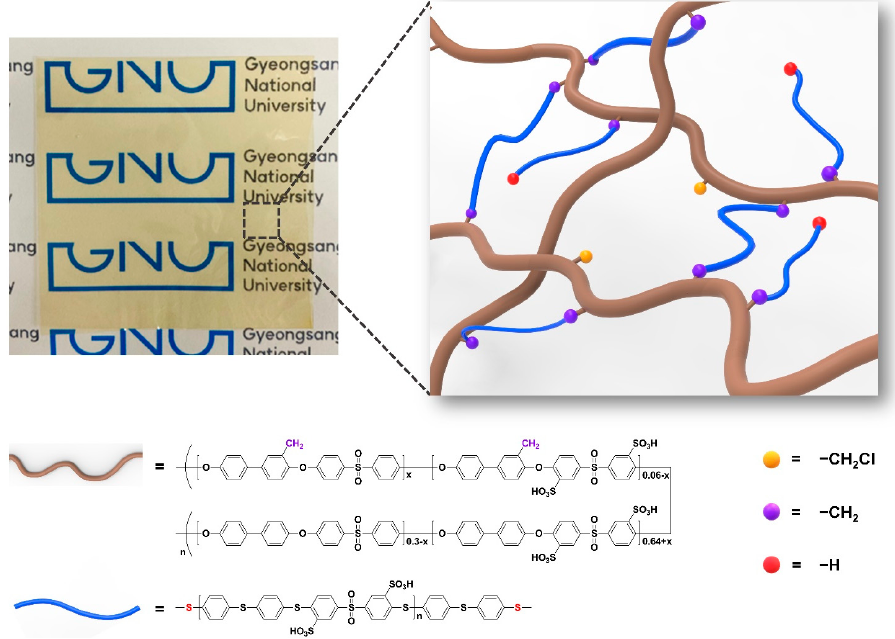
Figure 3. Schematic illustration of cross-linked SPAES membranes prepared with hydrophilic pol- ymeric cross-linker (SDT). Table 2. Solubility test of SPAES, SDT-CSPAES and DT-CSPAES membranes.